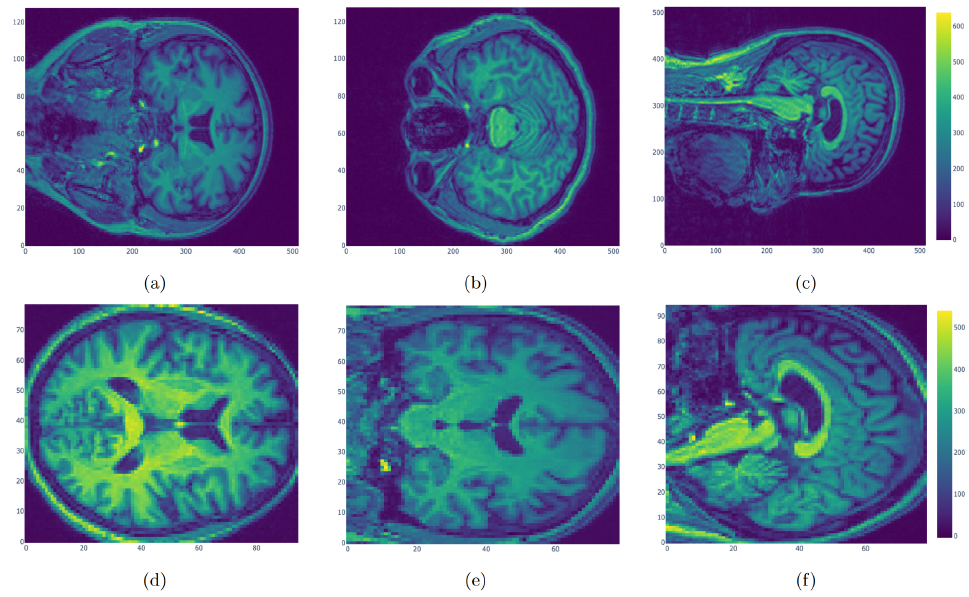
Figure 1. Original MRI images ( a – c ) and normalized MRI images ( d – f ). The original images of size (512, 512, 128) were normalized using Statistical Parametric Mapping. Individual images for all subjects were mapped to a common reference space with size (79, 95, 79) to reduce the